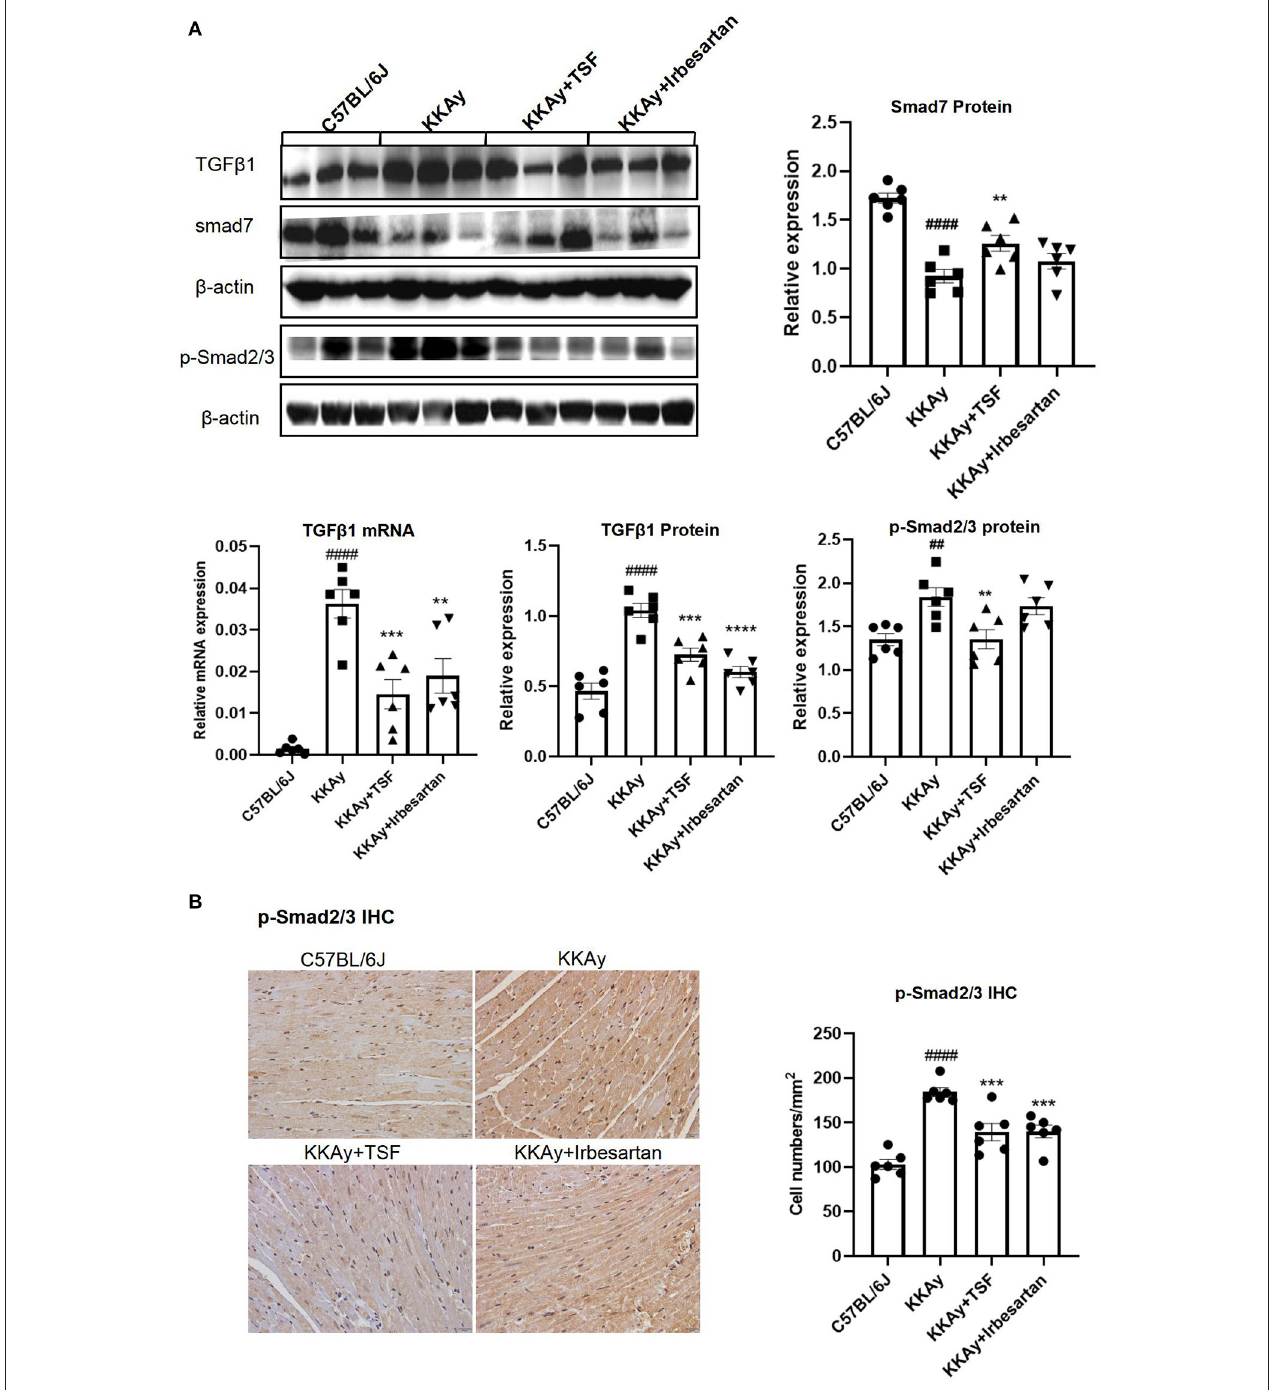
FIGURE 3 | Tangshen Formula treatment inhibited the expression of transforming growth factor- β 1 (TGF- β 1) and p-Smad2/3 and promoted the expression of smad7 in KKAy mice. (A) Western blot and semi-quantitative analyses of TGF- β 1, smad7, p-Smad2/3, and Smad2/3 expressions. (B) IHC of psmad2/3 (original magnification, 400 × ) and the number of positive cells in each group. Data are presented as mean ± SEM. ** p < 0.01, *** p < 0.001, **** p < 0.0001 TSF-treated group vs. KKAy group; ## p < 0.01, #### p < 0.0001 KKAy group vs. C57BL/6J group.